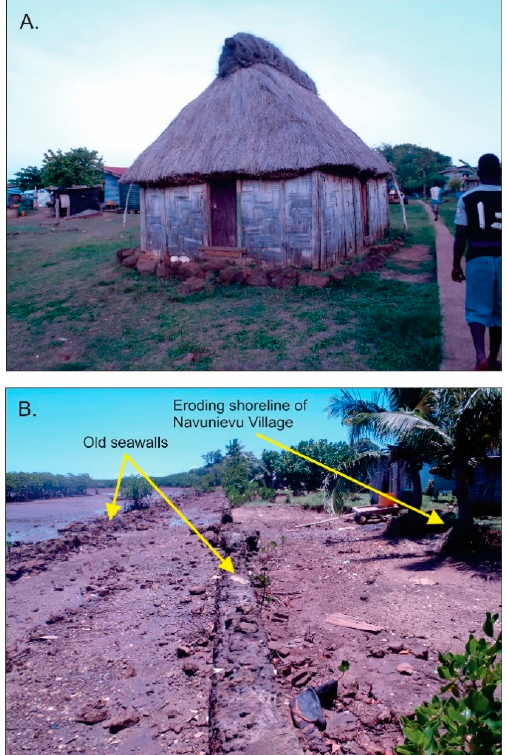
Figure A3. Photos from Bua (photos by authors). ( A ) Traditional housing in Denimanu Village on Yadua Island is preferred by many residents because it is cooler in hot weather and warmer in cool weather compared to many stronger house designs that are easier to construct. ( B ) The effects of sea-level rise over the past few decades are clearly visible along the shorefront of Navunievu Village, where seawalls built in the 1970s and 1990s have both now collapsed and the land on which the village is built is being slowly